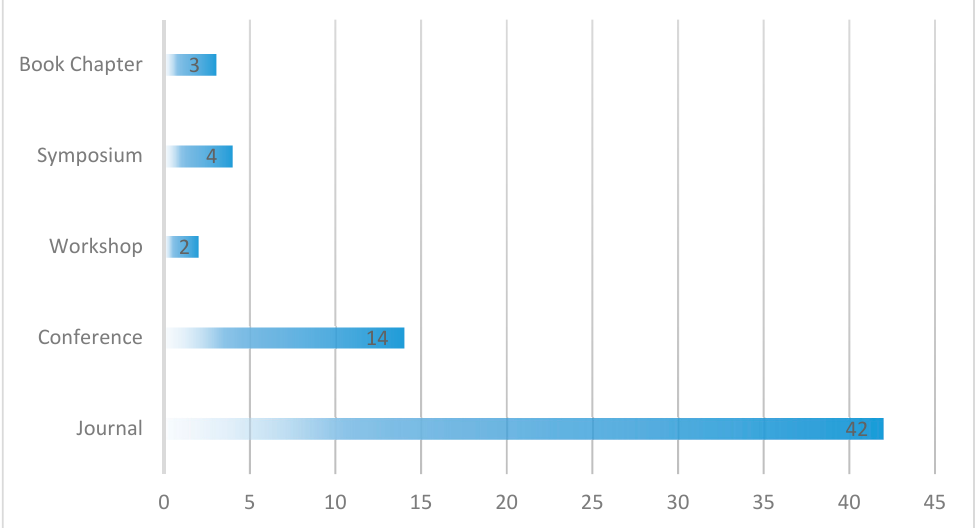
Figure 9. Publication types of the selected papers. Table 4. Publication channels.